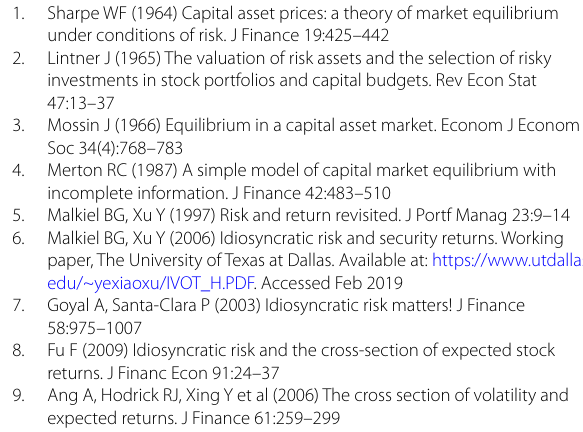
*Significant at 5%